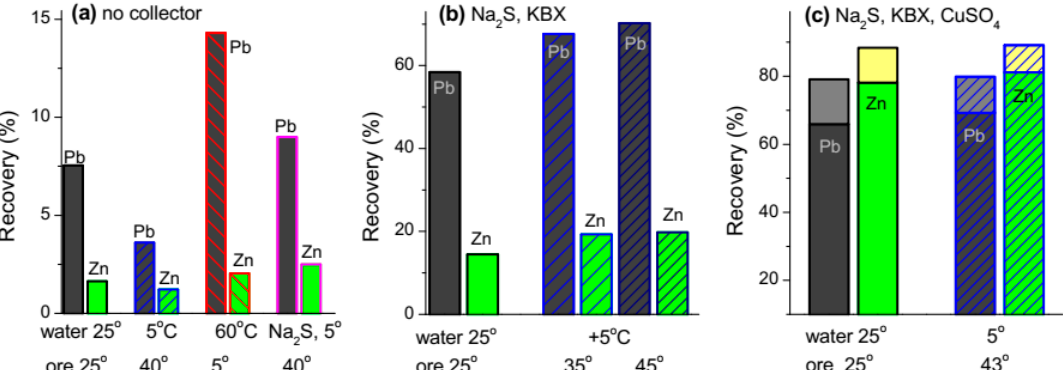
Figure 6. The results of bulk sulfide flotation (recoveries of Pb and Zn) from Gorevskoye Pb-Zn sulfide ore in various reagent scheme with and without the temperature difference pretreatment (the temperatures of aqueous phase and ore are shown at abscissa). ( a ) No collector added: no TD pre-treatment (both water and ore of about 25 ◦ C); ore heated to 40 ◦ C, water cooled to 5 ◦ ; ore cooled to 5 ◦ , water heated to 60 ◦ C; Na 2 S (100 g / t) added to the mill, ore heated to 40 ◦ C, water cooled to 5 ◦ . ( b ): Na 2 S (100 g / t) and Na 2 CO 3 (1000 g / t) were added to the mill, KBX (150 g / t) and frother T-92 (50 g / t) was dosed to flotation cell (pH 9.2, 20 ◦ C), temperature pre-treatment regimes are shown at abscissa. ( c ) Na 2 S (100 g / t) and Na 2 CO 3 (2000 g / t) were added to the mill, KBX (150 g / t), frother T-92 (50 g / t) and CuSO 4 (200 g / t) were dosed to the flotation cell, the upper parts of the columns show additional recoveries in one-step tail